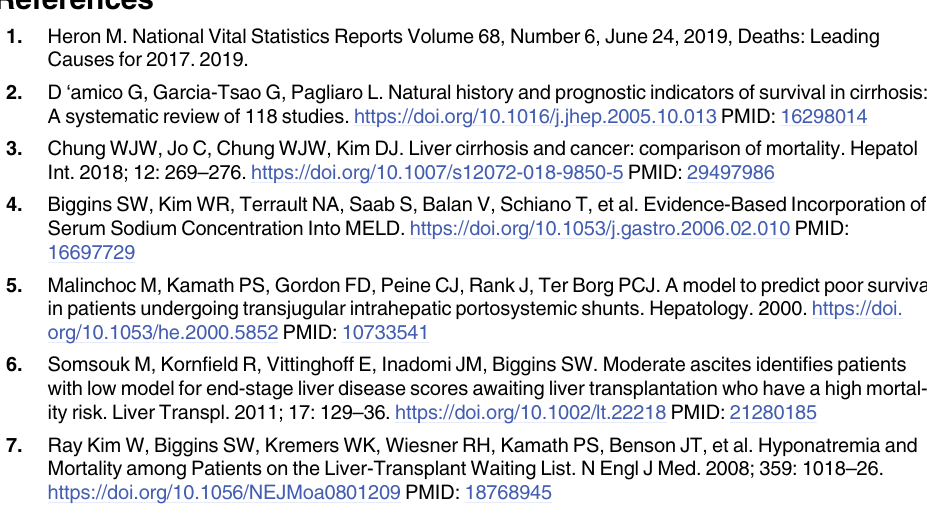
S1 Fig. Prediction performance by deep neural network (DNN), random forest (RF) and logistic regression (LR) with mean imputation strategy. Figure a, b, c is for the case of mor- tality within 365 days, 180 days, and 90 days, respectively. S1 Table. The study features and feature description. S2 Table. Prediction metrics [n (%)] of 3 period cases for 3 machine learning models with mean strategy for imputation. S3 Table. Prediction metrics [n (%)] of 3 machine learning models under 10 different tra- deoffs for case of 365